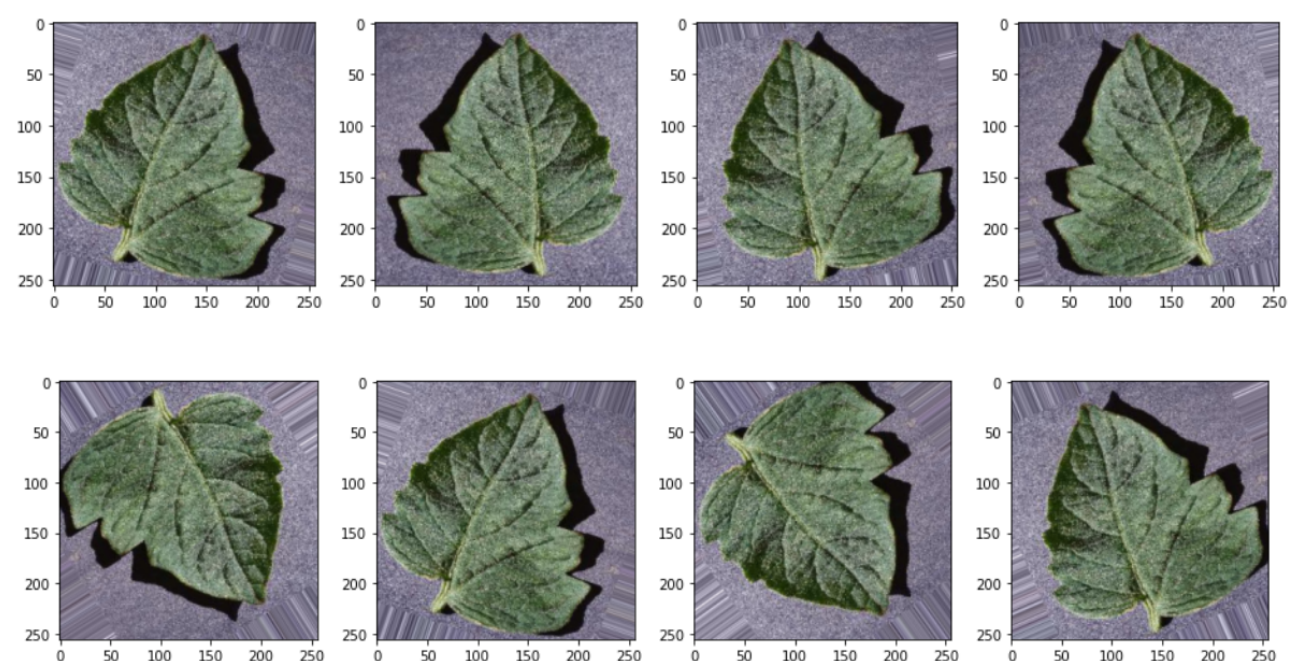
Figure 2. An augmented sample in the training dataset using classical geometric